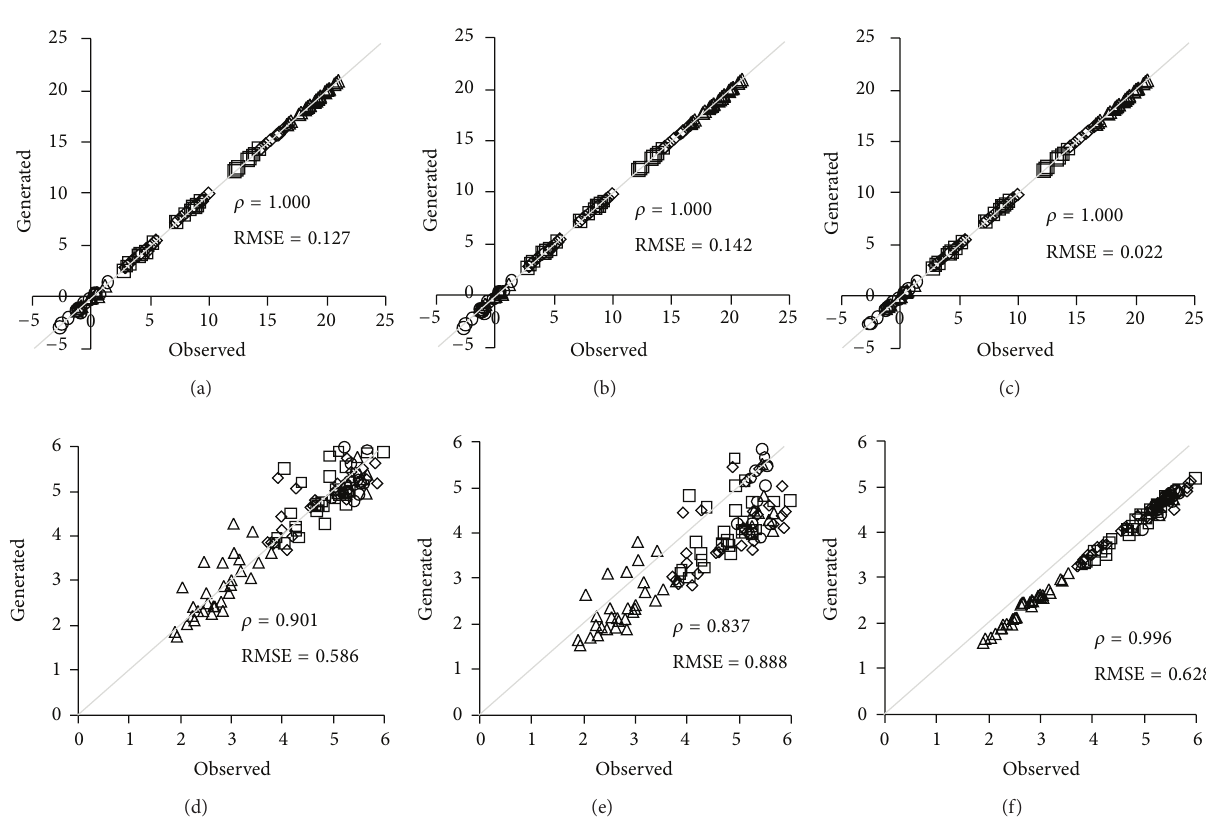
Figure 8: Comparison between observed versus generated ((a), (b), (c)) mean minimum temperatures ( ∘ C) and ((d), (e), (f)) standard deviations of minimum temperatures ( ∘ C) for each month. ((a), (d)) First model, ((b), (e)) second model, and ((c), (f)) third model. ( I